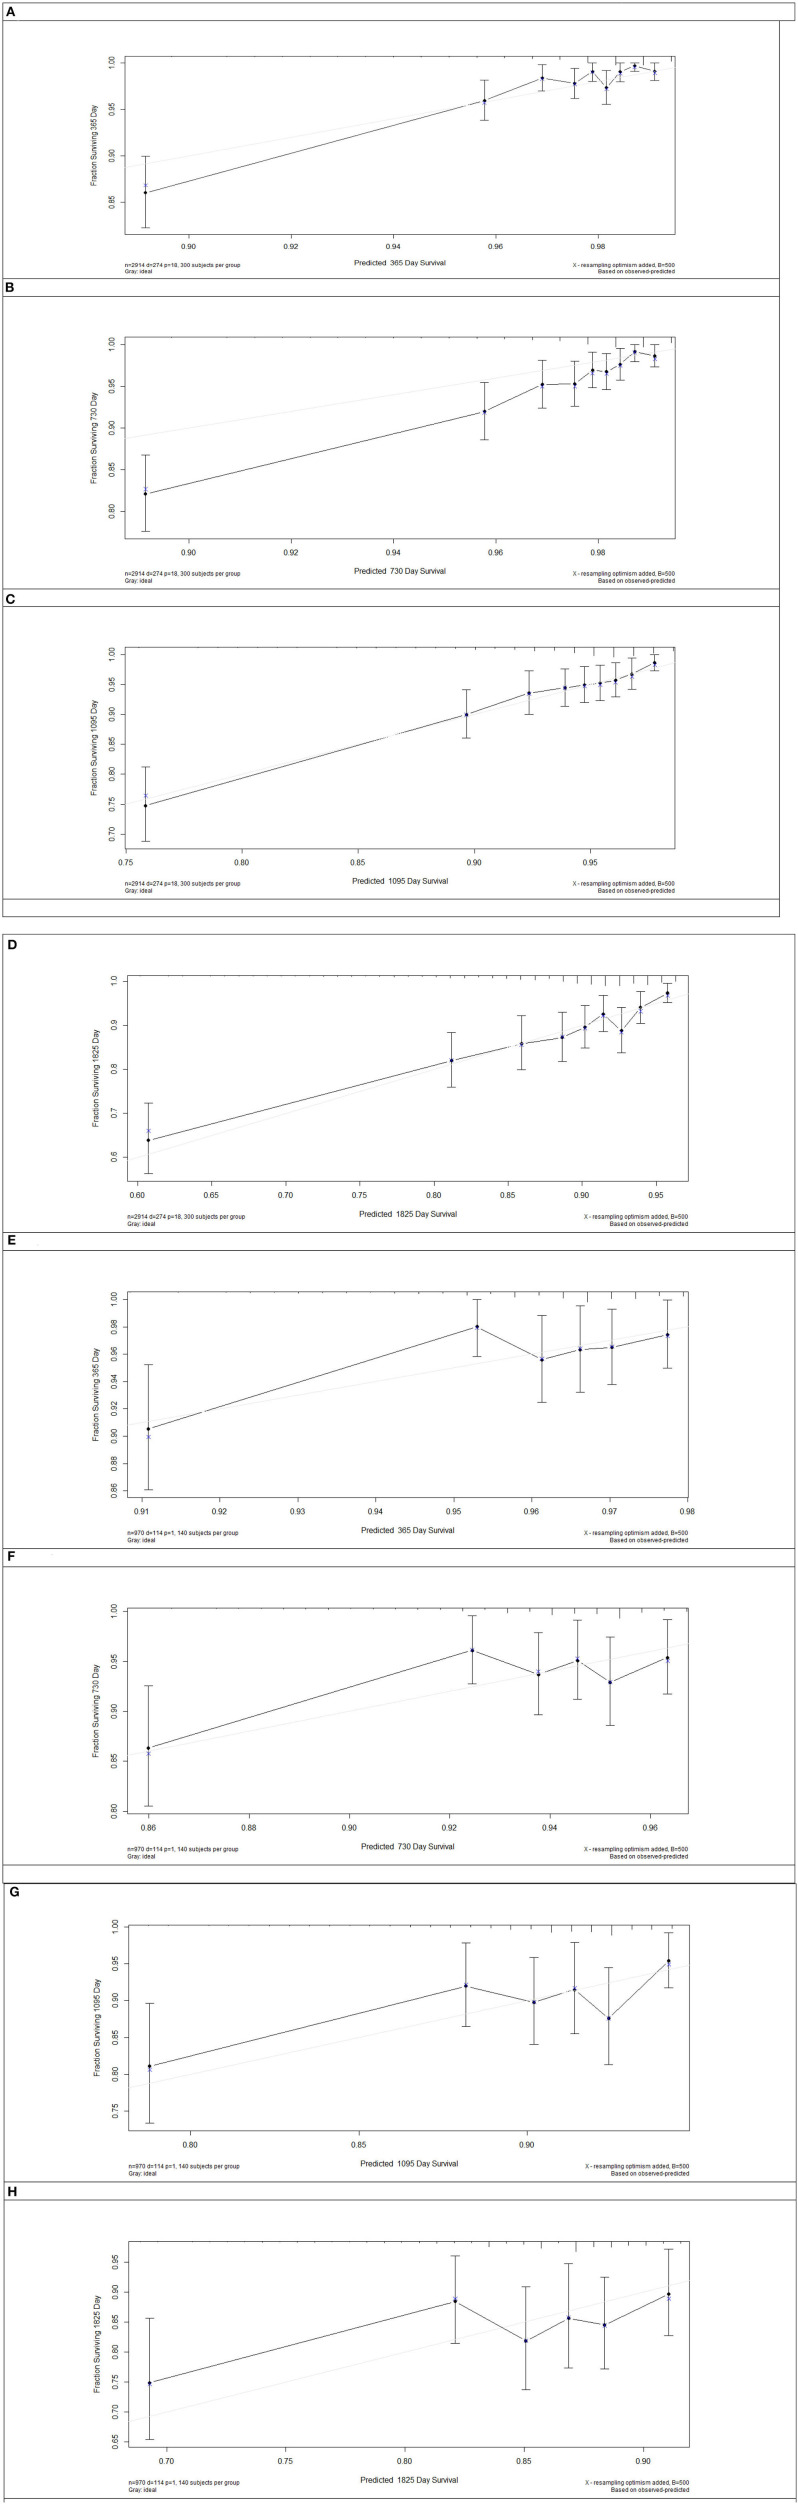
Risk score calibration in the derivation cohort and internal validation cohort. The major adverse cardiovascular events risk score of 1 (A), 2 (B), 3 (C), and 5 years (D) in the derivation cohort and 1 (E), 2 (F), 3 (G), and 5 years (H) in the validation cohort. Calibration is shown as the estimated risk against survival from Kaplan–Meier analysis. Gray line = perfect calibration.